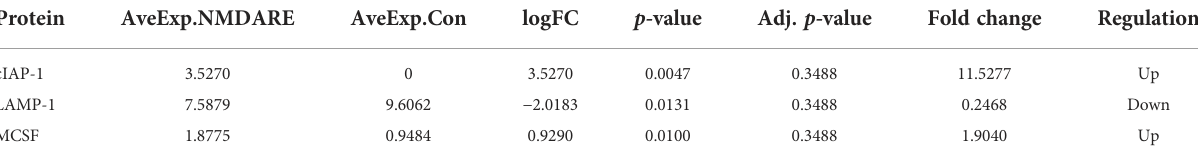
Table lists the three CSF biomarker candidates for NMDARE. A positive fold change indicates that the protein is upregulated in the NMDARE group in contrast to the control group. Differential analysis between groups was undertaken using linear modeling with the package LIMMA. A negative fold change indicates that the protein is downregulated in the NMDARE group compared to the control group. p-value: moderated t-statistics; Adjust p-value: Benjamini – Hochberg. NMDARE, anti-N-methyl-D-aspartate receptor encephalitis; Con, controls; cIAP-1, Cellular inhibitor of apoptosis protein; LAMP-1, Lysosome-associated membrane protein 1; MCSF, macrophage colony-stimulating factor.